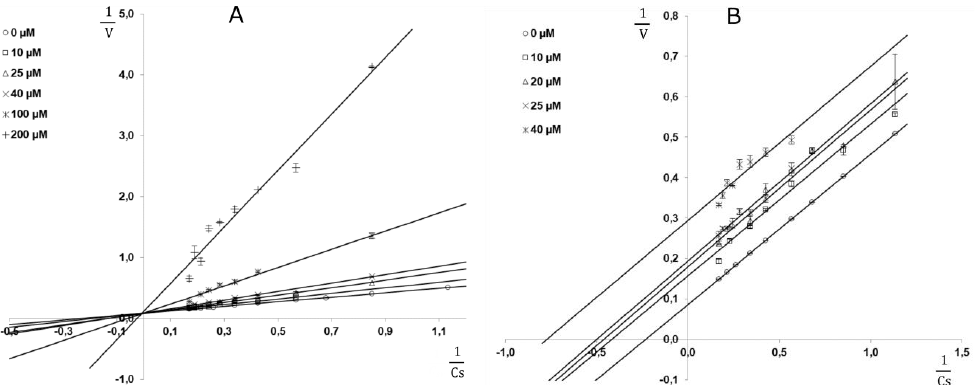
Figure 2. The representative Lineweaver-Burk plots 1 / V [min µ mol − 1 ] = f(1 / C S ) [ µ M –1 ] for laccase from Trametes versicolor in the presence of hydrazide-hydrazone 2b ( A ) and hydrazide-hydrazone 3c ( B ) tested in the range of concentrations 10 – 200 µM and 10 – 40 µM, respectively.